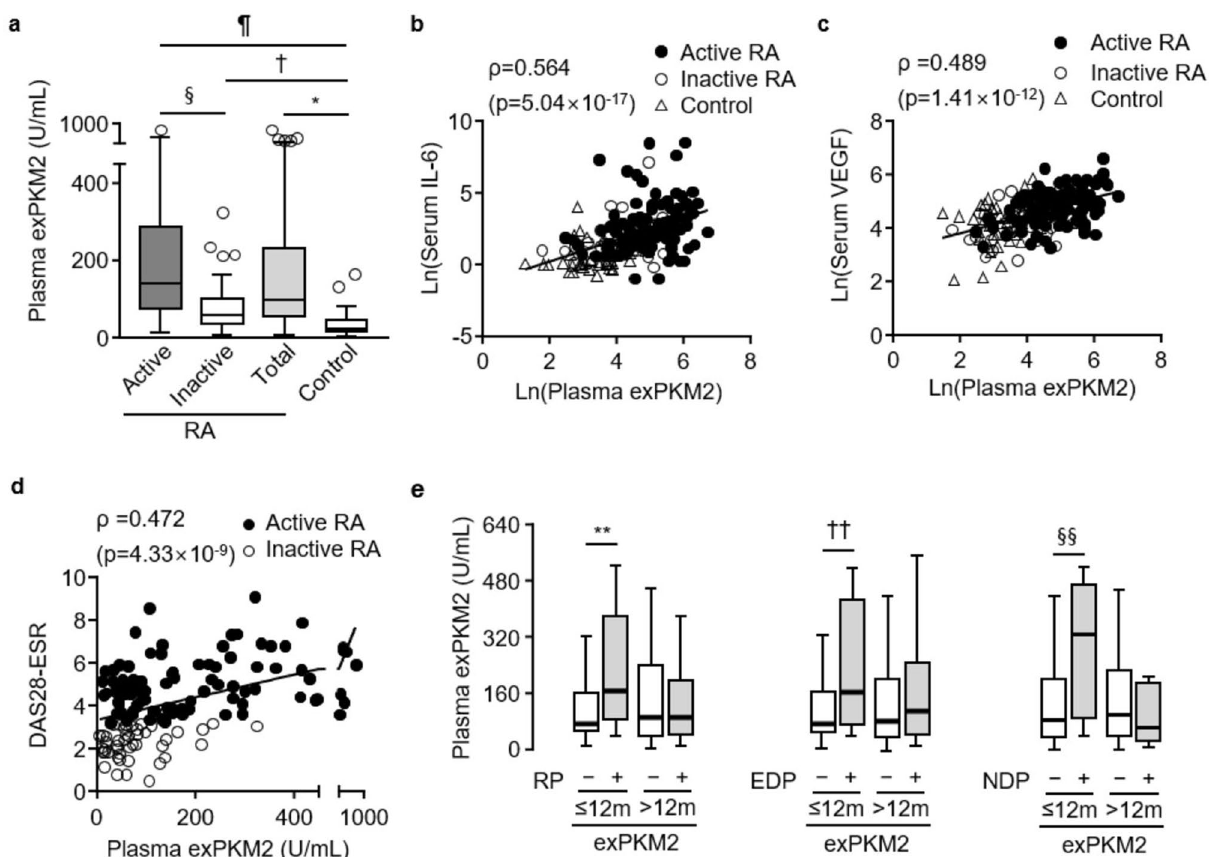
Figure 3. Circulating extracellular PKM2 (exPKM2) levels. levels in RA. ( a ) Plasma exPKM2 levels were significantly increased in total RA group (n = 139) and active (n = 94) or inactive (n = 45) RA subgroups when compared to control (n = 47) group (*p = 6.72 × 10 –13 ; † p c = 4.21 × 10 –4 ; ¶ p c = 8.76 × 10 –15 ; § p c = 1.71 × 10 –5 by the Mann–Whitney U test). ( b , c ) Plasma exPKM2 levels were positively correlated with serum IL-6 and VEGF levels in active and inactive RA patients and controls. ( d ) Plasma exPKM2 levels were significantly correlated with DAS28-ESR in active and inactive RA patients. ρ coefficients were calculated by the Spearman method. ( e ) Among early RA patients (disease duration < 12 months; n = 54), plasma exPKM2 levels were significantly increased in those with radiographic progression (RP), erosive disease progression (EDP), or narrowing disease progression (NDP). Data were plotted as box-and-whisker plots. **p = 0.017; †† p = 0.0017; §§ p = 0.024 by the Mann–Whitney U